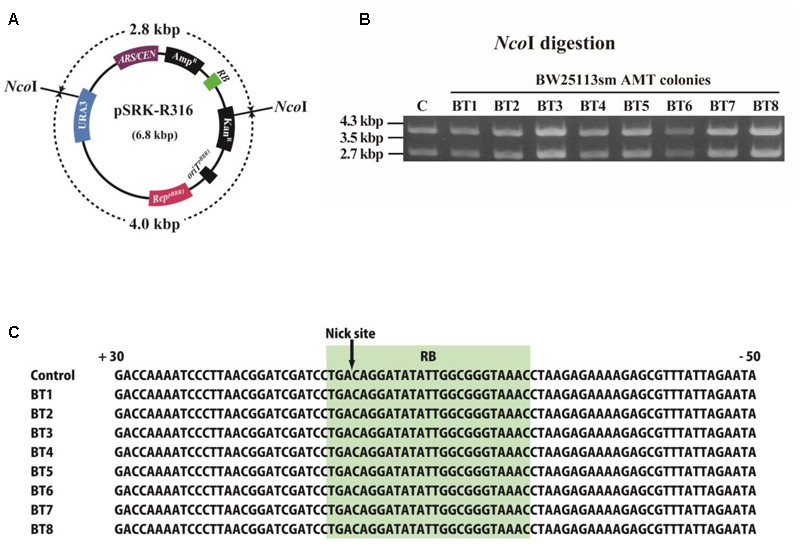
Structure of T-DNA circles extracted from E. coli transformant colonies. E. coli AMT offspring were obtained by co-cultivation with the donor strain EHA105 (pSRK-R316) and the recipient BW25113sm. (A) Physical map of pSRK-R316 showing the locations of two NcoI sites. (B) Extracted plasmid DNAs were digested by NcoI and separated by gel electrophoresis. Lane C: pSRK-R316, lanes 1 – 8: AMT colonies. (C) Alignment of RB junction sequences of plasmids extracted from the eight transformant colonies. The nucleotide sequence at the RB is shaded in light green.